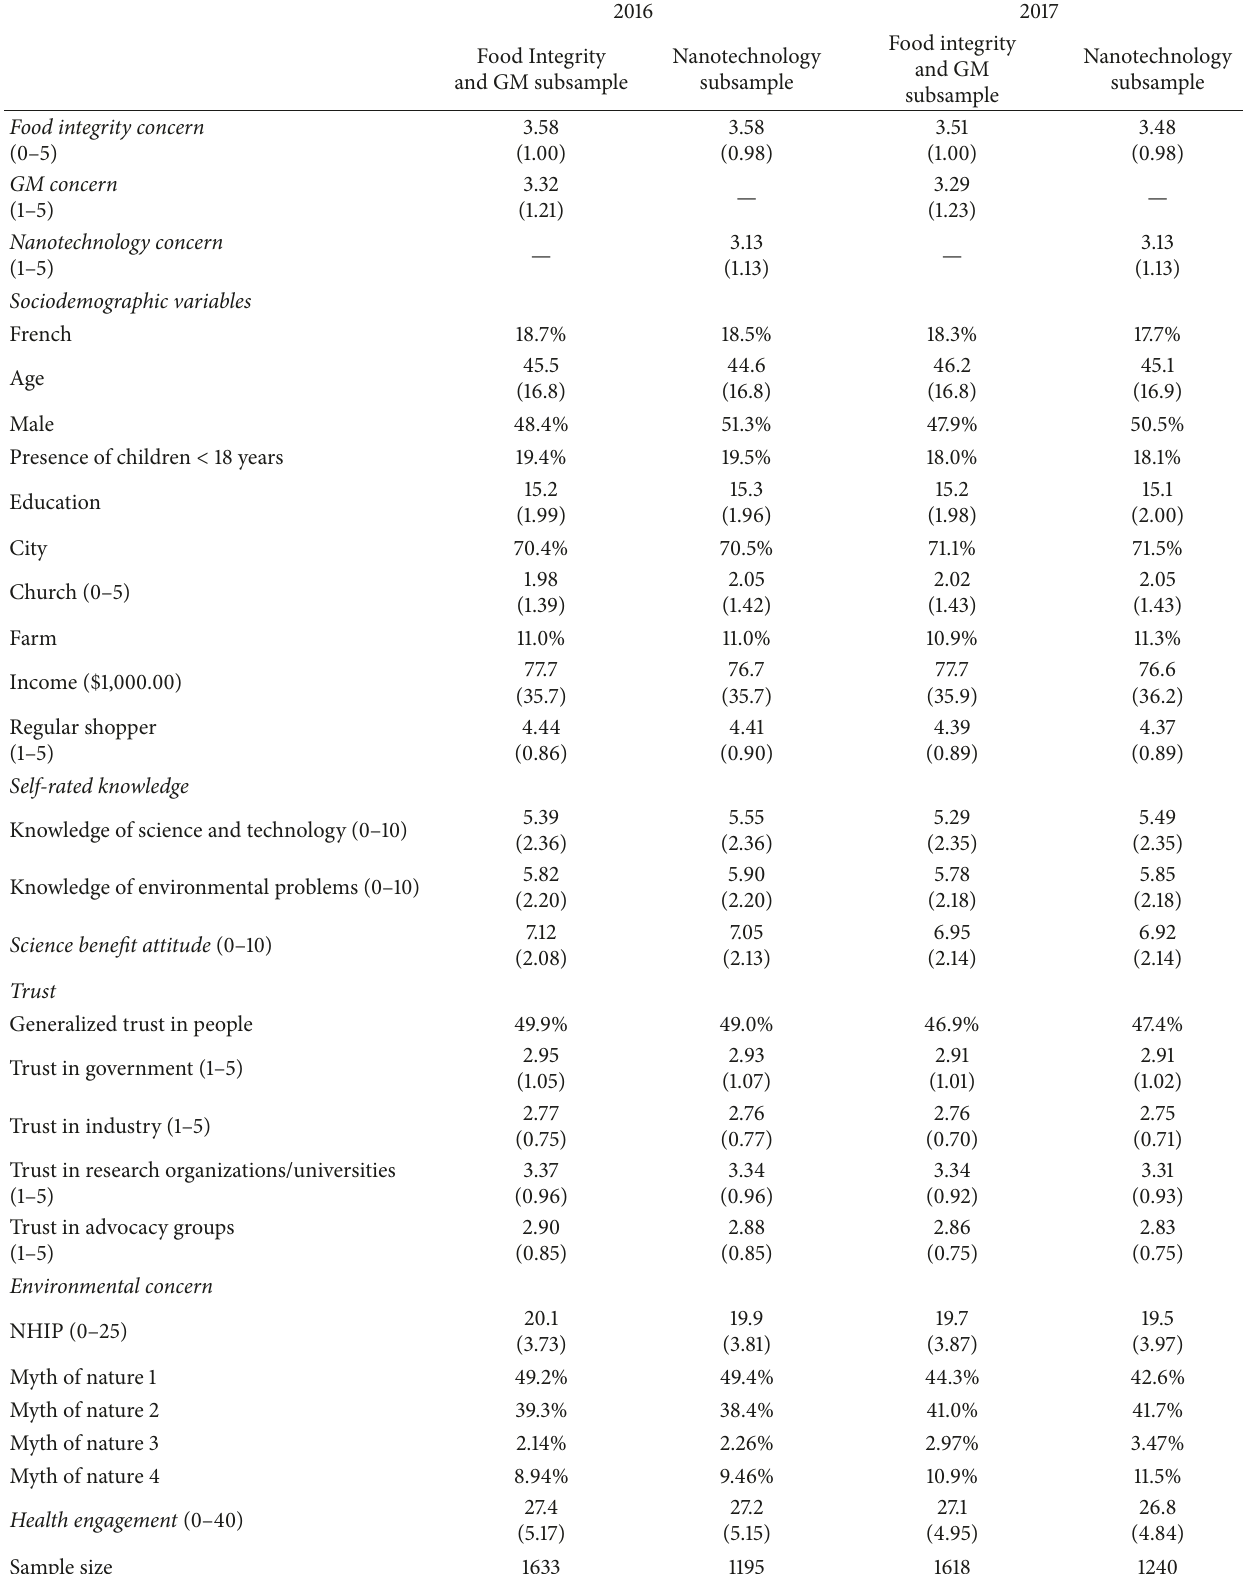
Table 4: Summary statistics for variables included in the